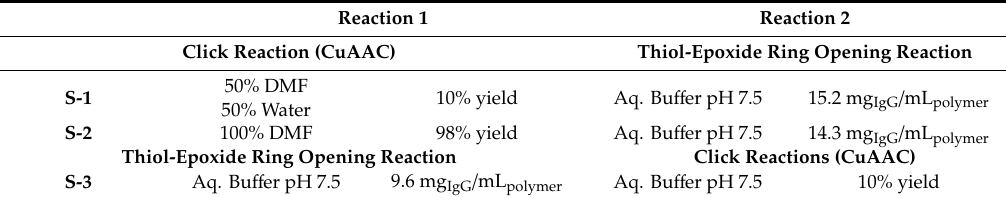
Figure 8. Chemical scheme for the chosen immobilization route starting from azide-containing microclusters. Table 4. Overview of conducted reactions yielding functional materials with covalently bounded staphylococcus aureus protein A.